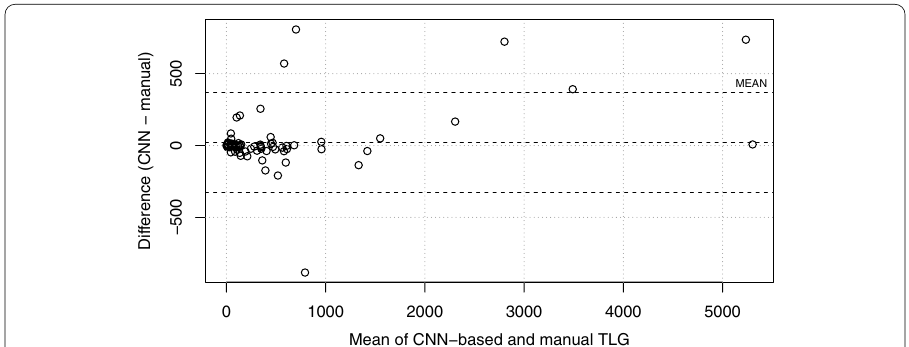
Fig. 1 Bland–Altman plot comparing CNN-based and manual TLG